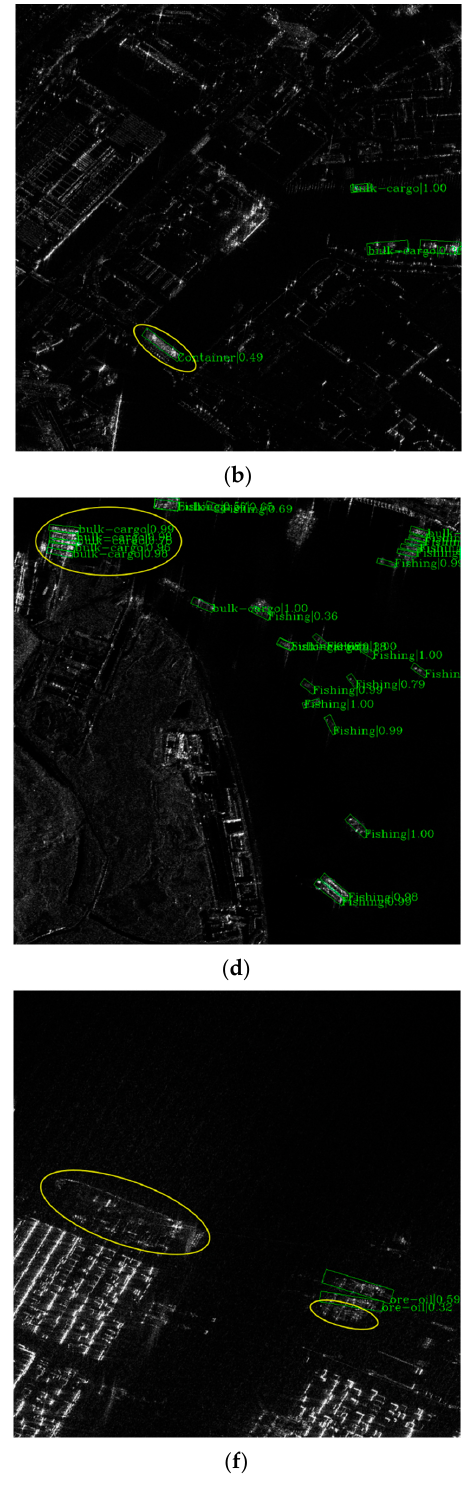
Figure 19. Some missed detection results, false detections, and false alarms in the dataset. ( a ) Ground truth; ( b ) false alarm; ( c ) ground truth; ( d ) false detections; ( e ) ground truth; ( f ) missed detections.